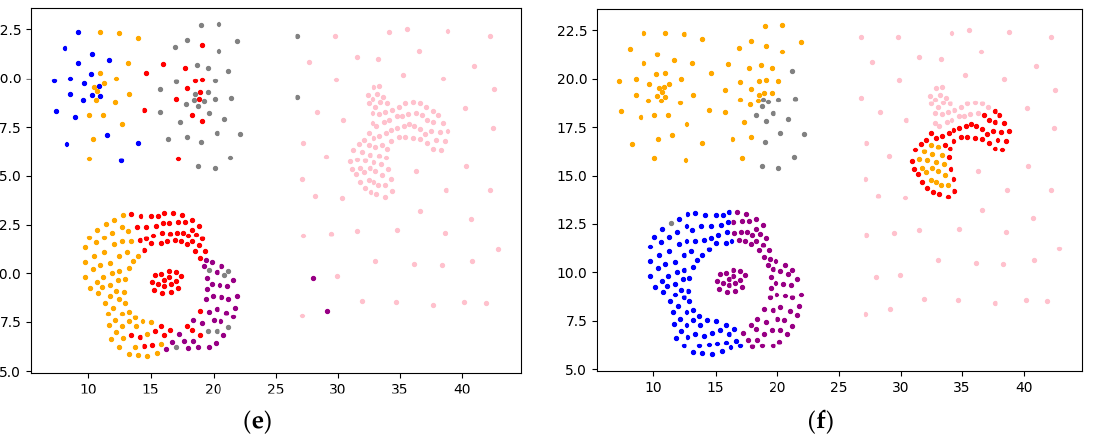
Figure 12. Visual analysis of Compound dataset [17,18] . ( a ) Original. ( b ) F-DPC. ( c ) DPC. ( d ) Reference [17]. ( e ) Reference [18]. ( f ) K-means.